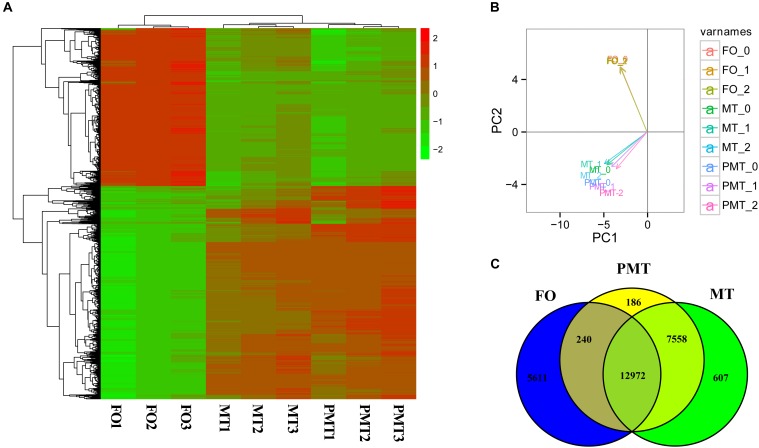
The expression profiles and DEGs among females, males and pseudomales in gonads. (A) Heatmap analysis of hierarchical clustering of DEGs in females (FO1, FO2, FO3), males (MT1, MT2, MT3), and pseudomales (PMT1, PMT2, PMT3). Each column represented an individual, and each row represented a gene. The FPKM was transformed by log10. Red color represented the high expressed genes, and green color represented the low expressed genes. (B) PCA plot of specimens. (C) Venn diagram shown the numbers of expressed genes and DEGs in FO, MT and PTM.